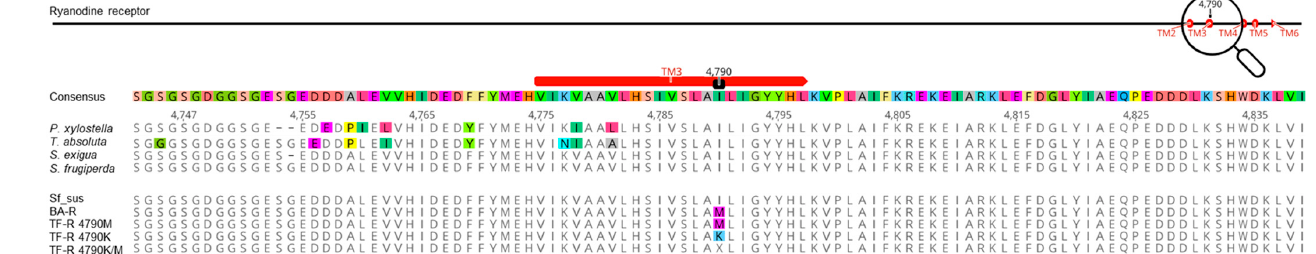
Figure 3. Ryanodine receptor (RyR) partial sequence alignment. Multiple alignment of the amino acid sequence of a partial region of the RyR of different lepidopteran species comprising the I4790M/K region linked to diamide resistance in selected Brazilian strains BA-R and TF-R of Spodoptera frugiperda . The accession numbers of the shown sequences are: Plutella xylostella (AET09964), Tuta absoluta (APC65631), Spodoptera exigua (AFC36359), S. frugiperda (MK226188), Sf_Sus (MK805909.1), BA-R (ON653045), TF-R 4790M (ON653048), TF-R 4790K (ON653047) and TF-R 4790K/M (ON653046).